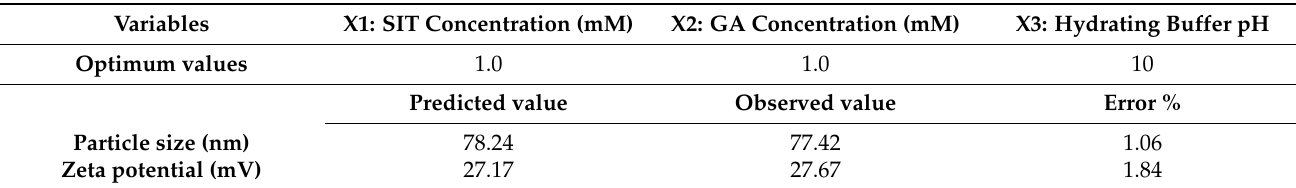
Table 3. Optimized variables levels of the optimal SIT-GA nano-conjugates with predicted and observed values of the responses.